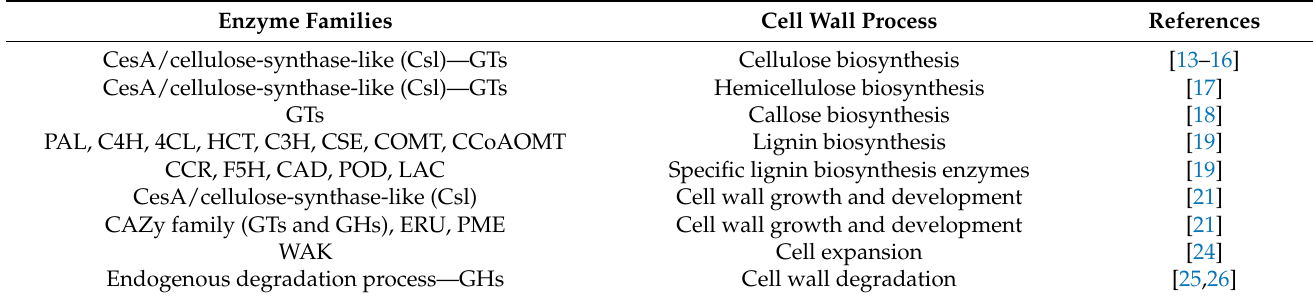
Table 2. Main enzyme families involved in cell wall biosynthesis, growth, development, and degradation.